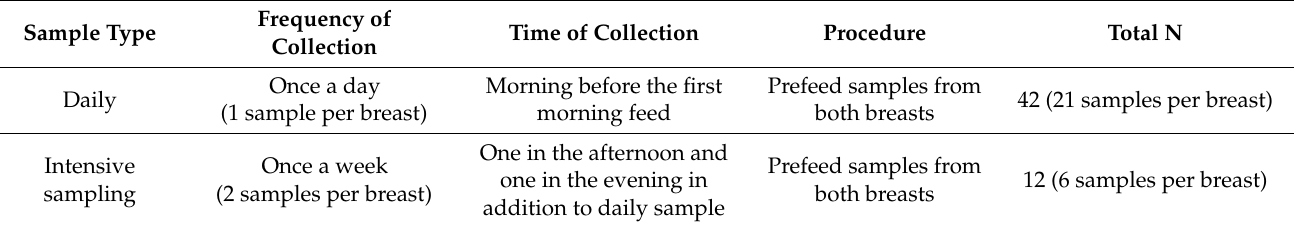
Table 1. Summary of sample collection for analysis of human milk composition across the entire 3 weeks of the study 1 . Sample